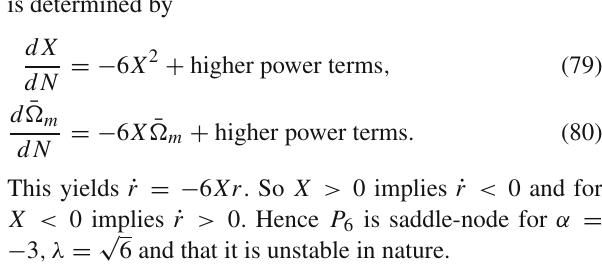
Table 5 D = 0: values of α and λ for λ 1 = λ 2 α ( ≈